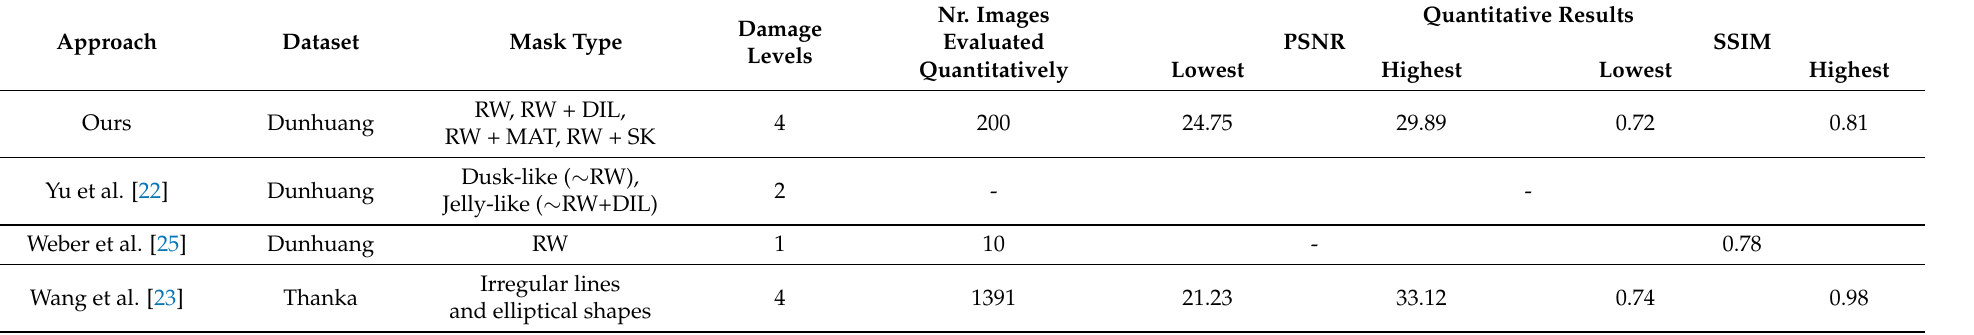
Table 2. Rough comparison between our method and other relevant related works solving the restoration of wall